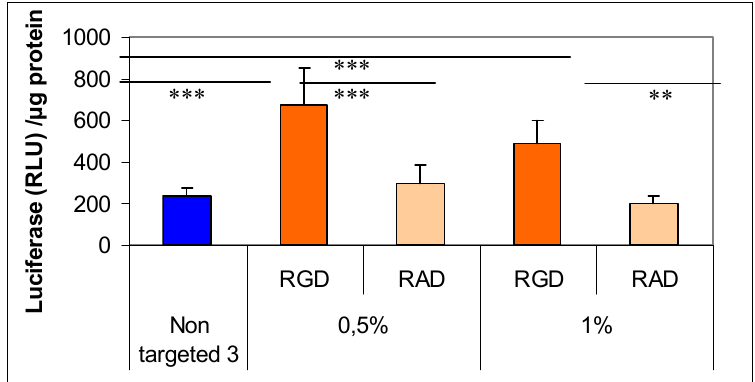
-lipid as Figure 7. Specific DNA (pCMV-luc plasmid) transfection of a RGD-PEG 2000 compared to a RAD-PEG -lipid incorpored in thiourea liposomes made of compound 3 2000 and to the non targeting pegylated liposomes made with compound 3 . Percentages represent the amount of PEG-lipid incorporated in the liposomes (mol/mol PEG-lipid/total lipid). Complexes were incubated 2 h with EAhy 926 endothelial cells. Relative light Unit (RLU)/µg protein refers to the amount of light measured normalised by the protein amount in each well. Values represent the mean +/ − SD of triplicates. Statistics were performed with the Mann- Whitney U-test (*** p < 0.001, ** p <